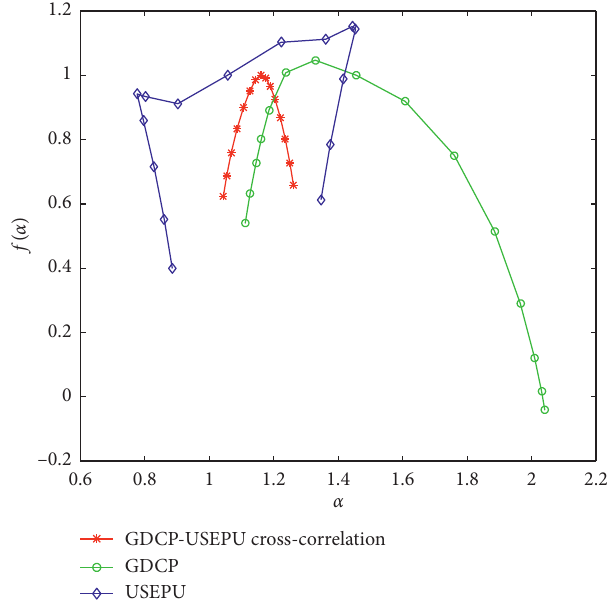
Figure 7: Spectrum singularity of f ( α ) versus α for GDCP and USEPU cross-correlation, the correlation of GDCP, and the cor- relation of USEPU. Table 2: Max, min, and delta values of the H¨older